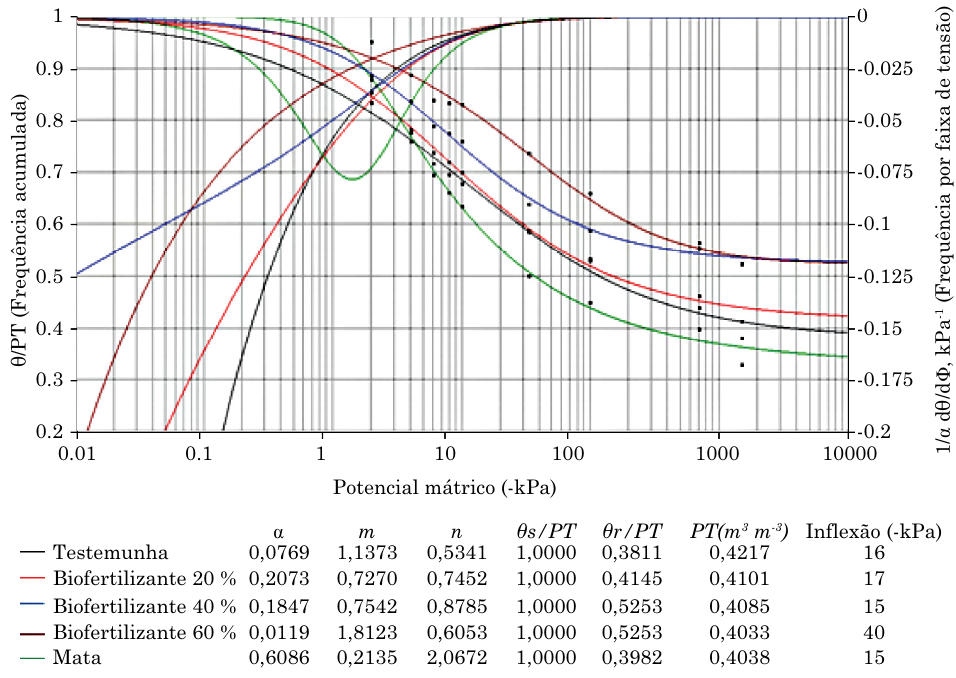
Figura 7. curva característica de água no solo e curva diferencial da curva característica de água no solo para as áreas sob cultivo de figo e mata secundária na camada de 0,1-0,2